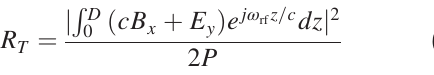
Fig. 2 the transverse particle momentum and offset are shown for the reference particle at three energies (2, 10,